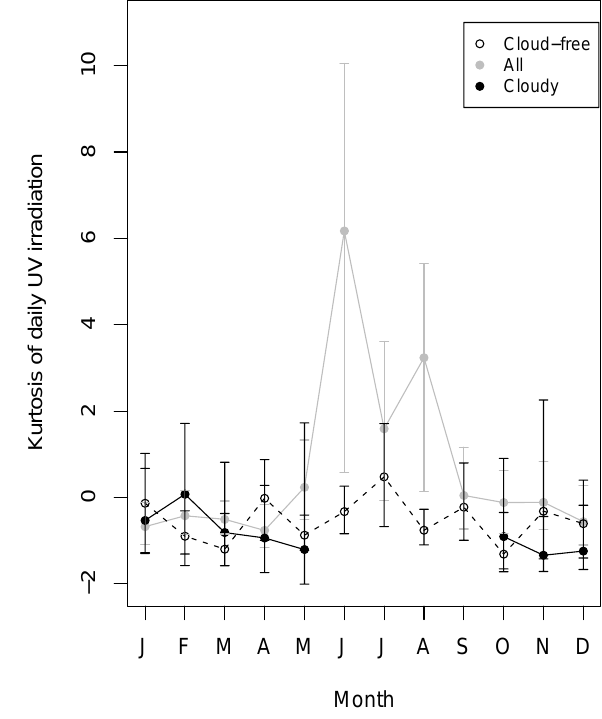
Fig. 7. Annual evolution of the skewness of daily ultraviolet erythemal irradiation.